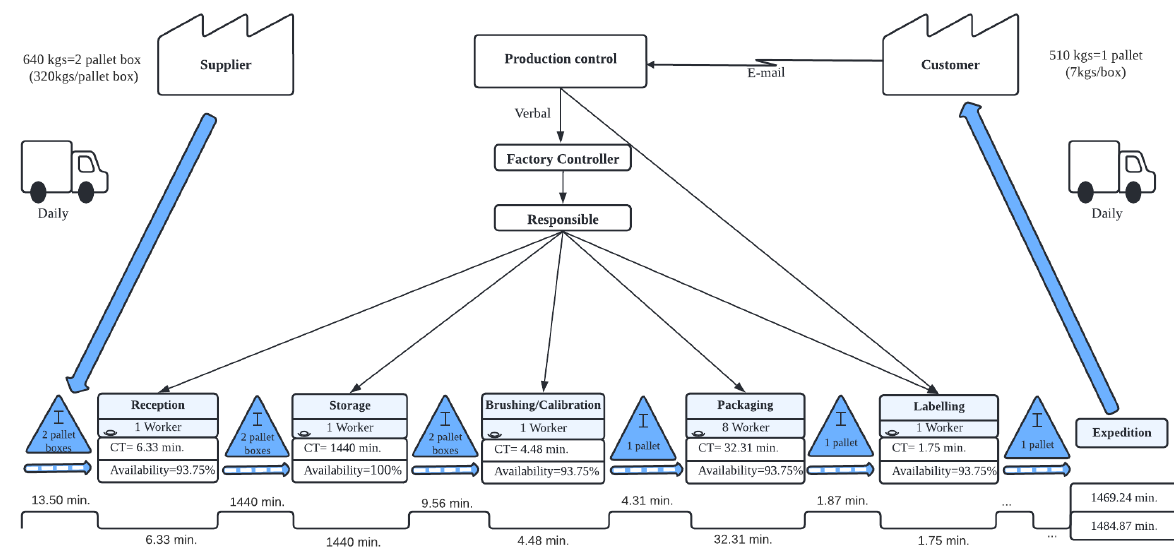
Figure 4. Current VSM of production.